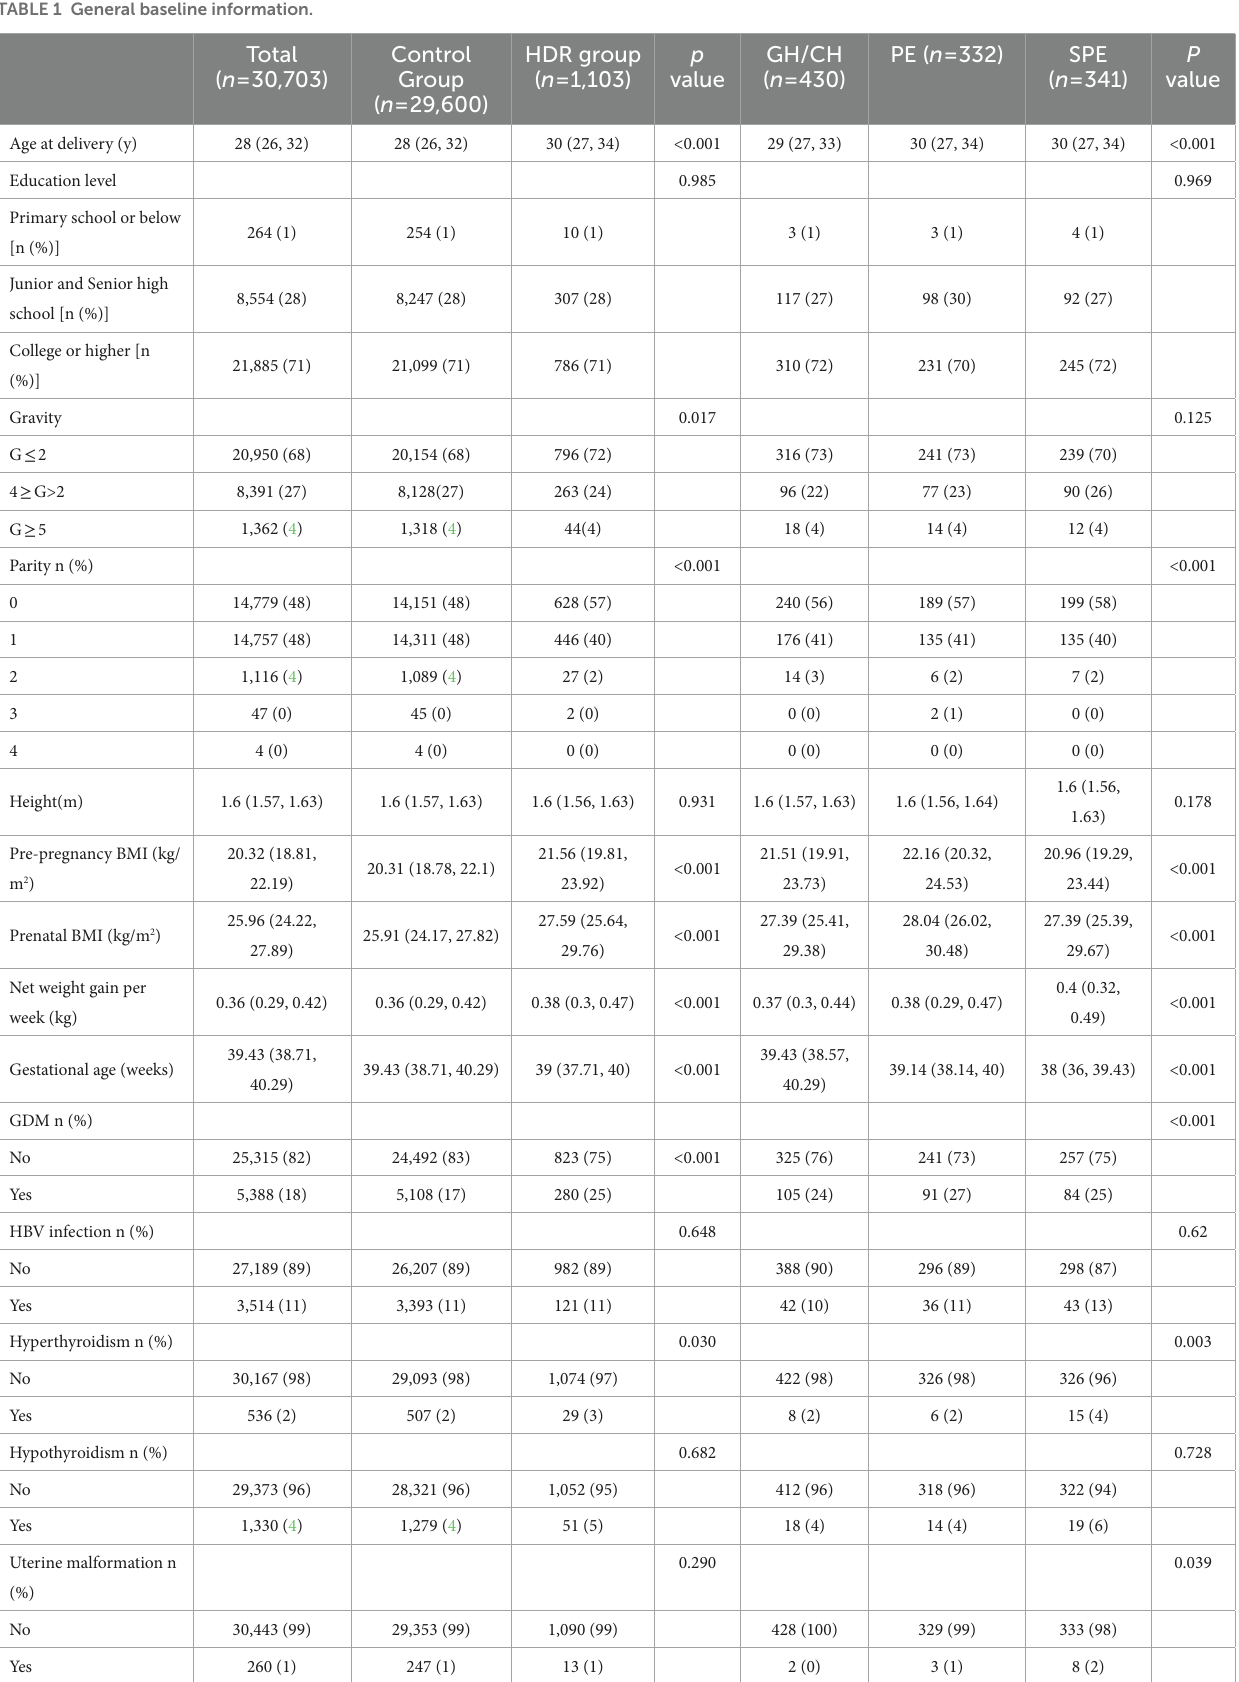
TABLE 1 General baseline